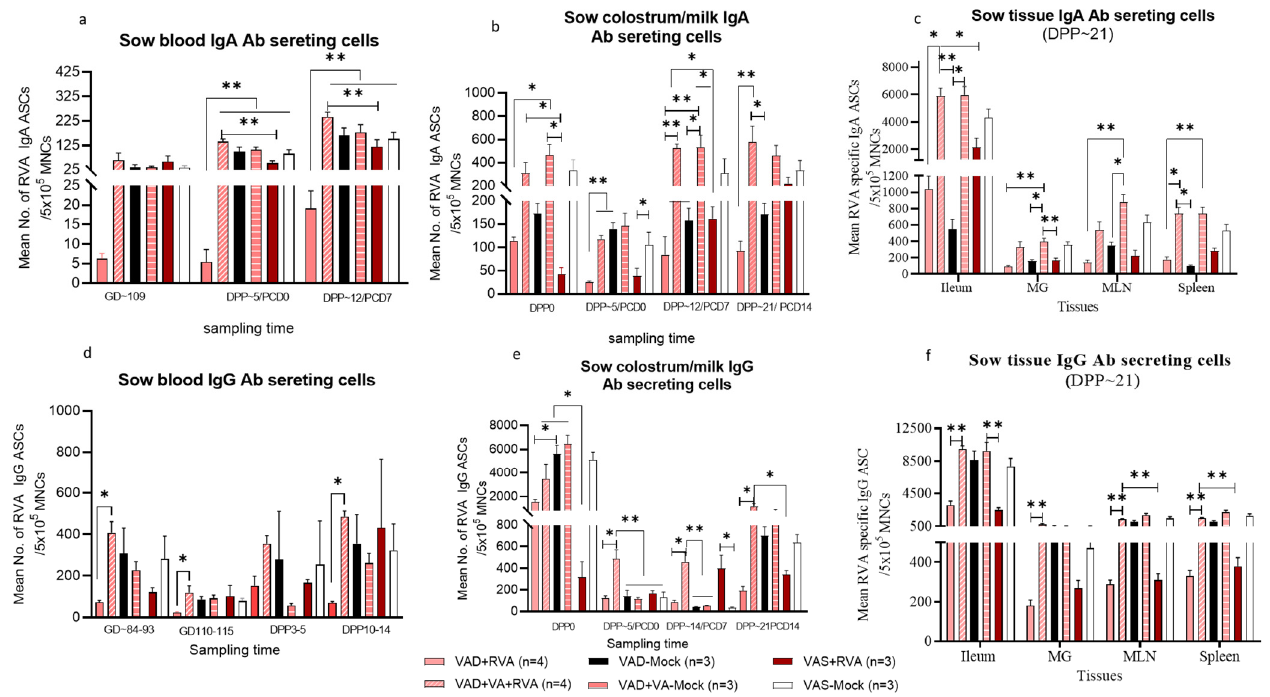
Figure 4. Mean RVA IgA antibody secreting cells ( a – c ) and mean RVA IgG antibody secreting cells ( d – f ) in Blood, milk, and tissues MNCs of RVA/mock inoculated sows fed VAS, VAD ( ± VA) diets during gestation and lactation. DPP—days postpartum, GD—gestation day, PCD—post challenge day (* p < 0.05; ** p < 0.01). MLN—mesenteric lymph node, MG—mammary gland.